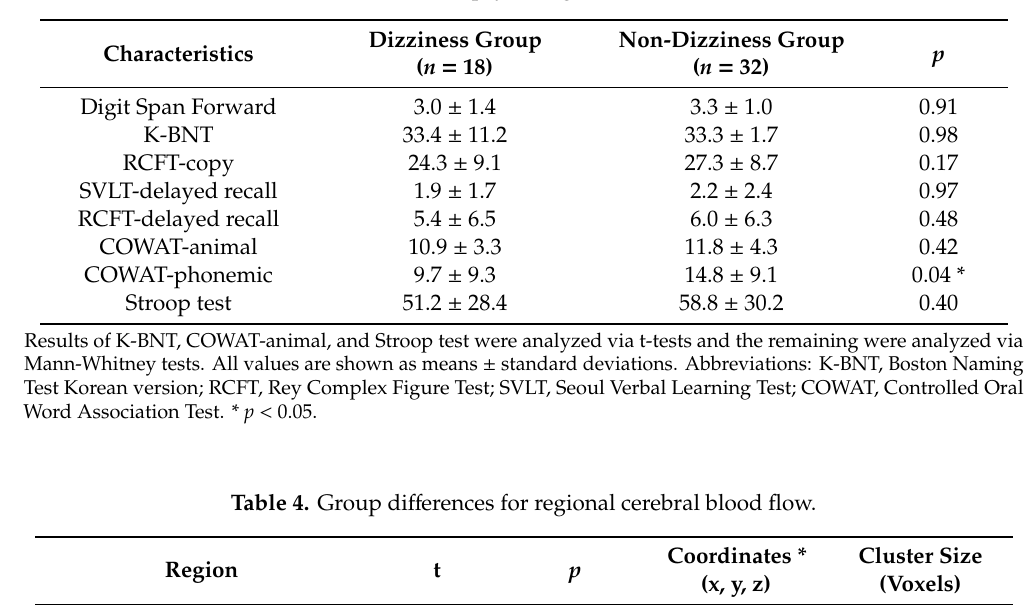
Table 3. Neuropsychological test results.